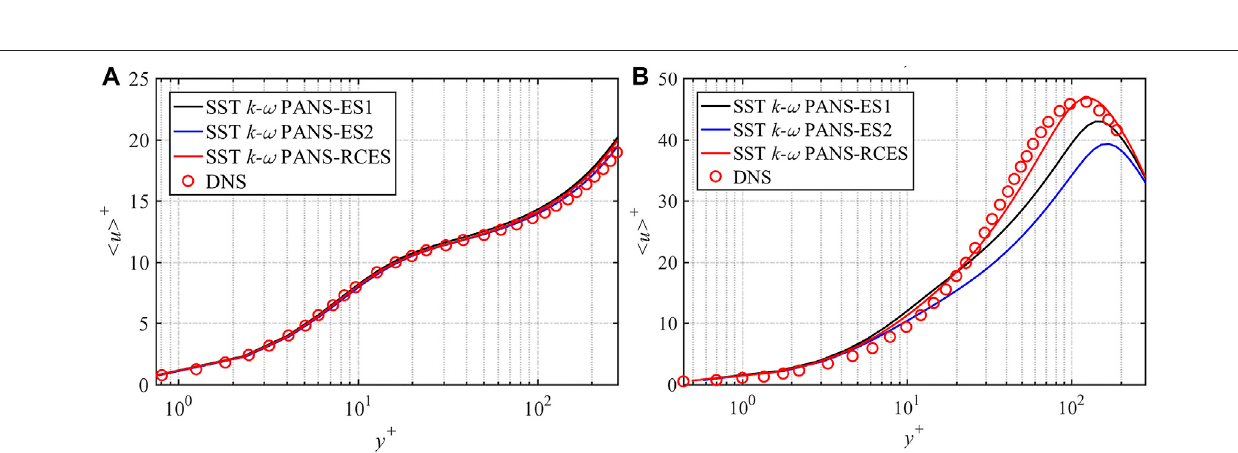
Frontiers in Energy Research |